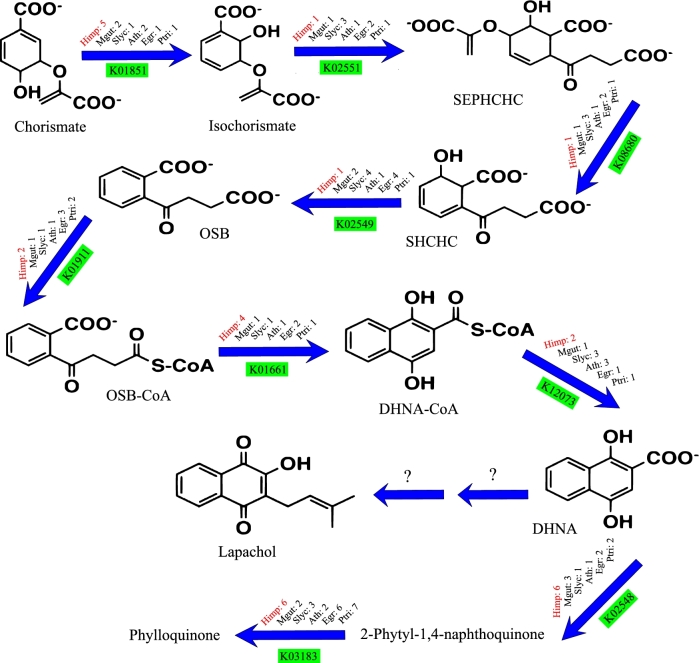
Genes of the biosynthetic pathway of specialized quinoids. O-succinylbenzoate (OSB) pathway depicting the number of H. impetiginosus (Himp) annotated genes for the known enzymes that lead to the biosynthesis of the naphthoquinones, including lapachol. For comparison, it also shows the numbers of genes for the closely related Mimulus guttatus (Mgut), Solanum lycopersicum (Slyc), for the model Arabidopsis thaliana (Ath), and for the tree species Eucalyptus grandis (Egr) and Populus trichocarpa (Potri). The pathway was modified from Widhalm and Rhodes [89].